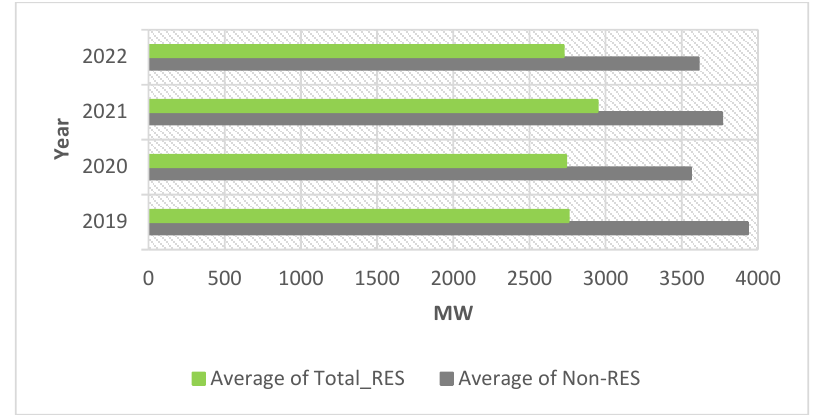
Figure 7. Total RES and non-RES from 2019 to 2022. Table 1. Correlation coefficients between consumption and generation sources in 2019.